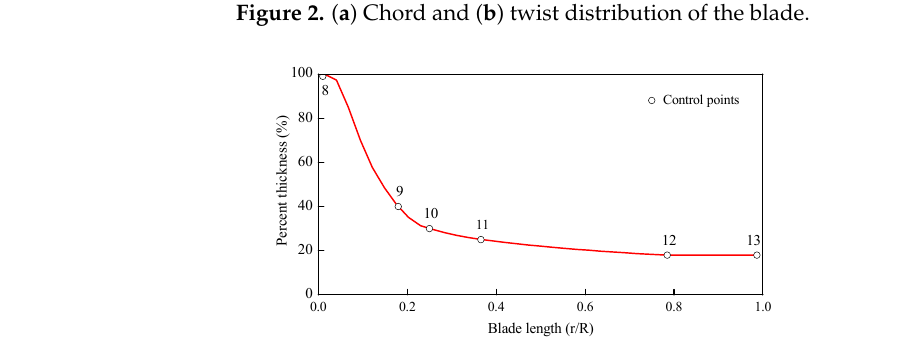
Figure 3. Percent thickness distribution of the blade.